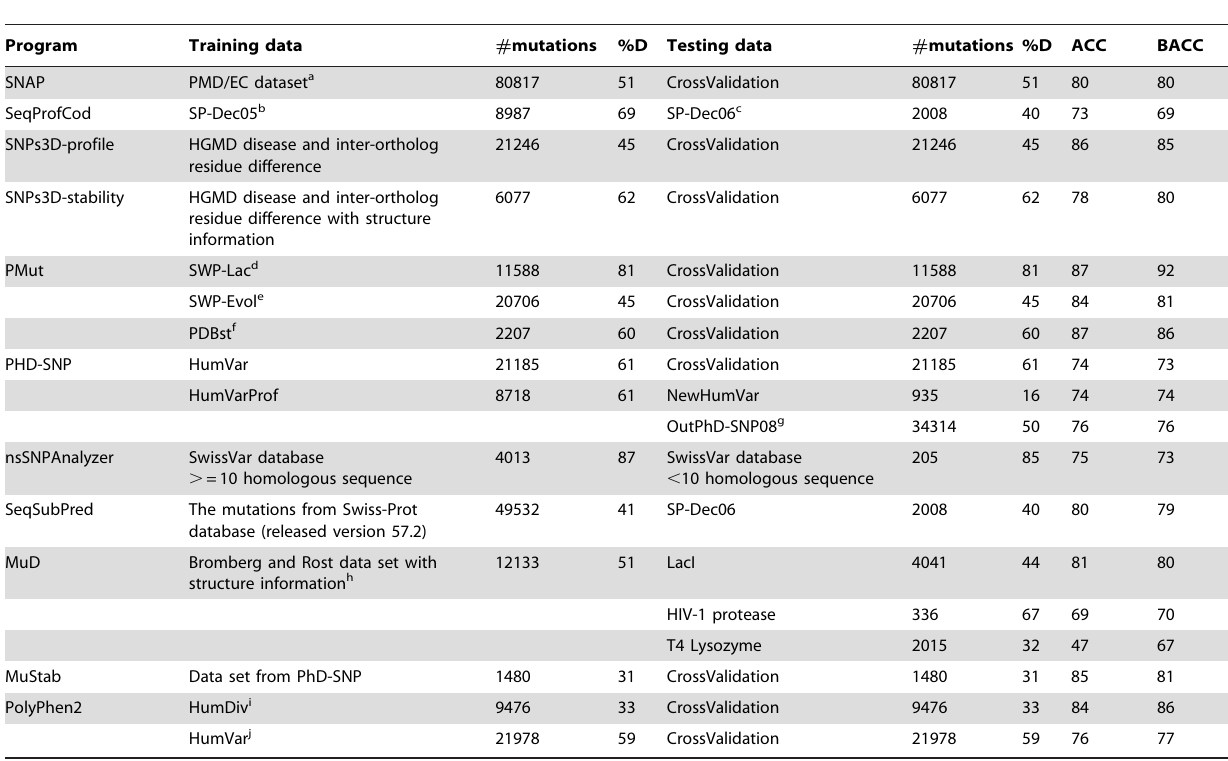
Table 1. The # mutations and percentage of deleterious mutations for published